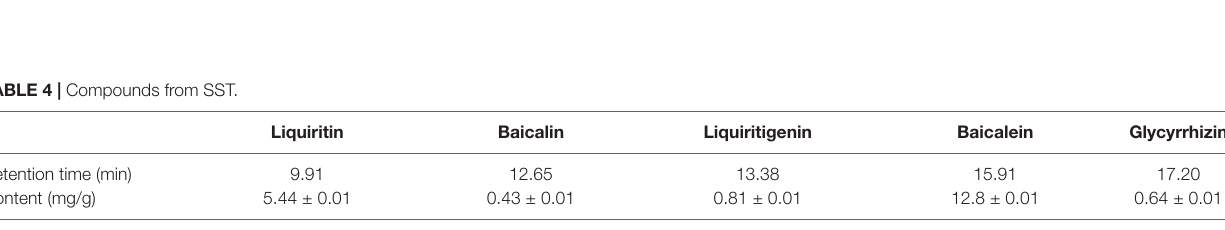
FIGURE 1 | Ultra performance liquid chromatography (UPLC) analysis of Soshiho-tang (SST). (1) Liquiritin, (2) Baicalin, (3) Liquiritigenin, (4) Baicalein, (5) Glycyrrhizin.